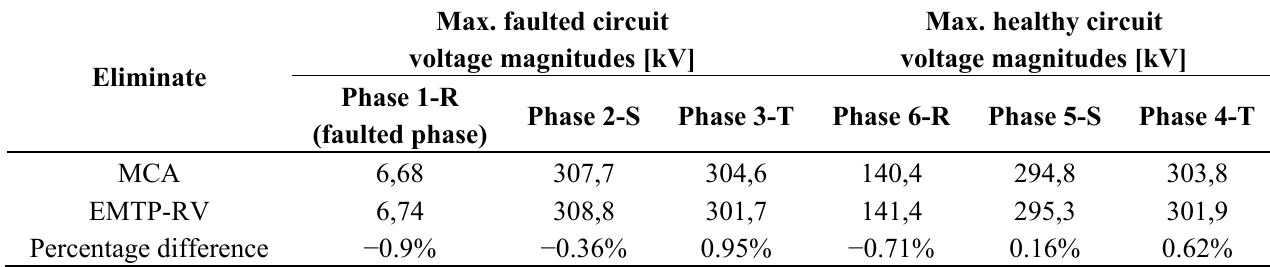
Table 5. Double-circuit line maximum voltage magnitude comparison.